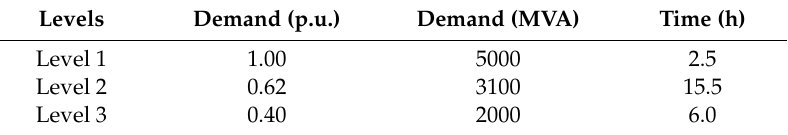
Table 2. Load duration curve information used for the